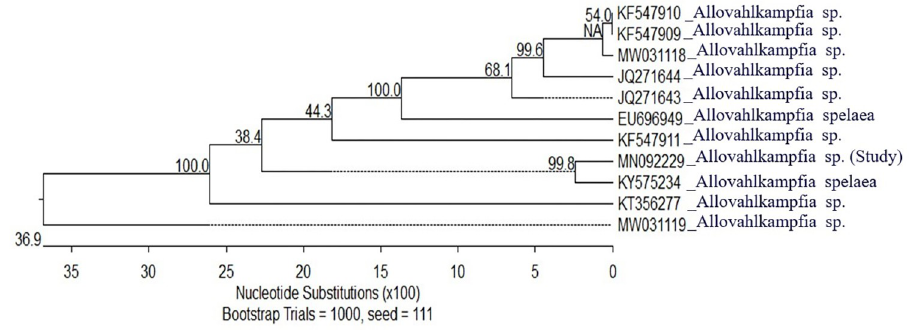
Fig 9. Phylogenetic tree showing the evolutionary relationship among Allovahlkampfia spp. The scale below shows the number of substitutions in 100 nucleotides and corresponds to the branch length. Dashed branches indicate negative branches. The values at bifurcations show the node support value in the 1000 bootstrap trials. NA indicates the absence of bootstrapping for the respective node.